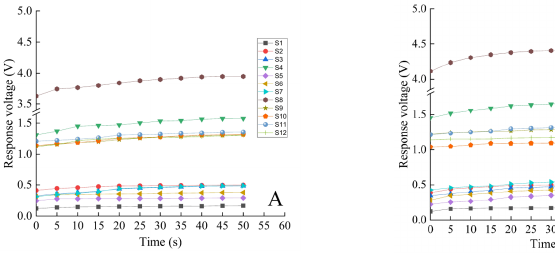
Figure 4. The response curves given by the sensor: ( A ) sample of treatment A; ( B ) sample of treat- ment B; ( C ) sample of naturally ripe fruit. S1-S12 represents different sensor,